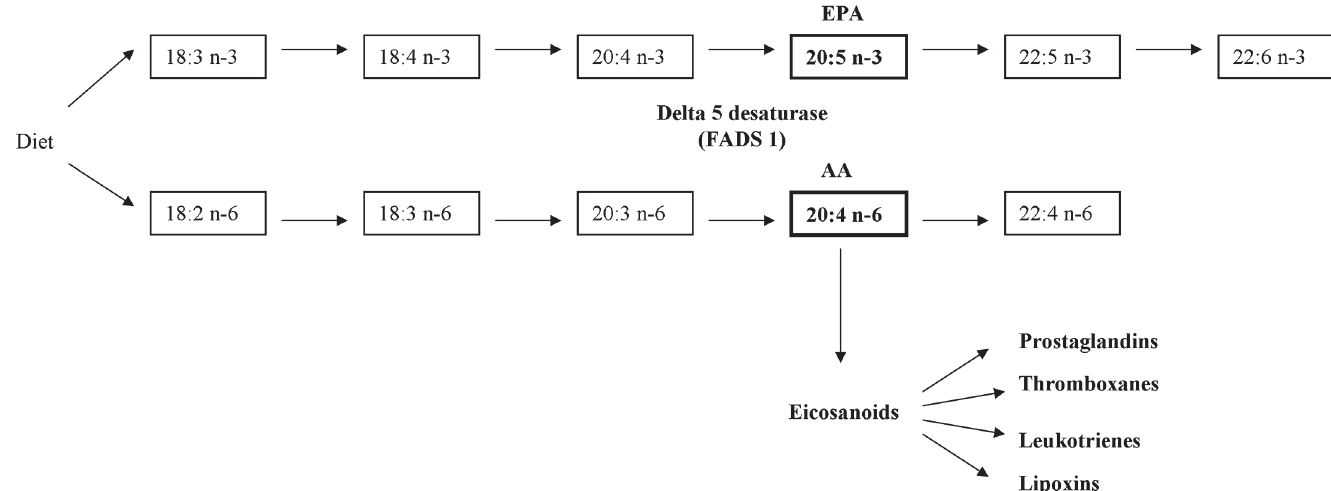
Fig 1. The n-3 and n-6 PUFAs metabolism pathways. AA, arachidonic acid; EPA, eicosapentaenoic acid; FADS: fatty acid desaturase.